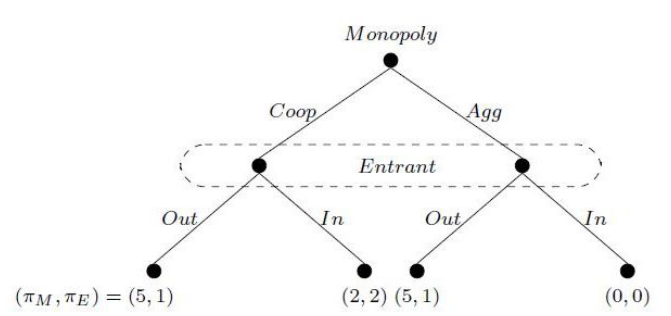
Figure 3. The One-Stage Trockel’s